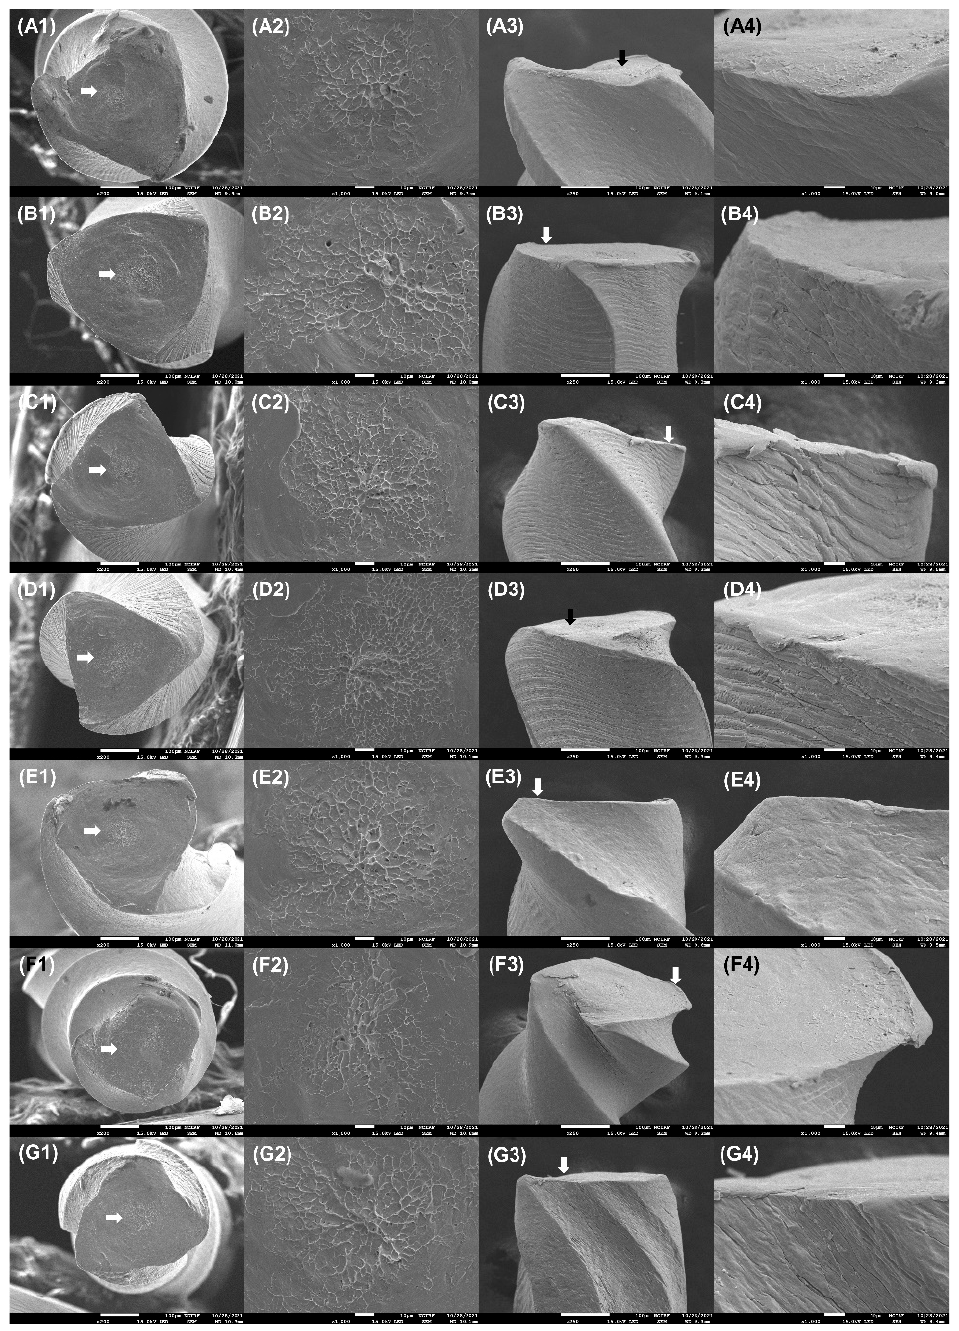
Figure 5. SEM images after the torsional resistance test of ( A ) ProFile, ( B ) ProTaper Gold, ( C ) ProfaTaper Gold, ( D ) HyFlex CM, ( E ) V Taper 2H, ( F ) 2Shape, and ( G ) K3XF. ( A1 – G1 ) Fractured surfaces (×200); ( A2 – G2 ) magnified (×1000) view of fractured surfaces at the arrow region in ( A1 – G1 ), showing circular abrasion marks; ( A3 – G3 ) lateral surfaces (×250), showing plastic deformation; ( A4 – G4 ) magnified (×1000) view of fractured surfaces at the arrow regions in ( A3 – G3 ), indicating the absence of cracks.